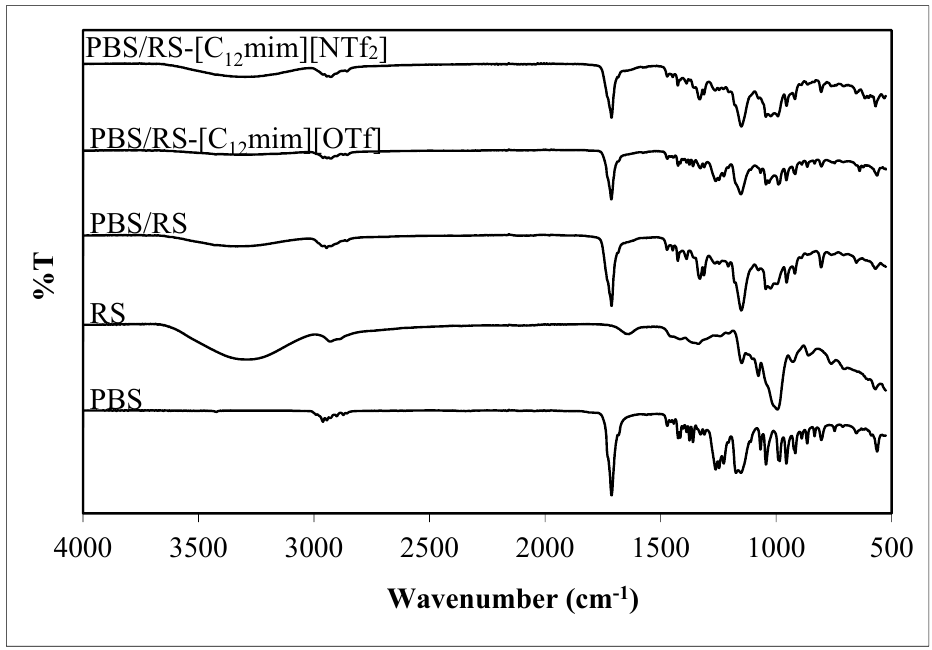
Figure 3. FTIR spectra of the PBS, RS and PBS/RS blends without and with containing ILbS.